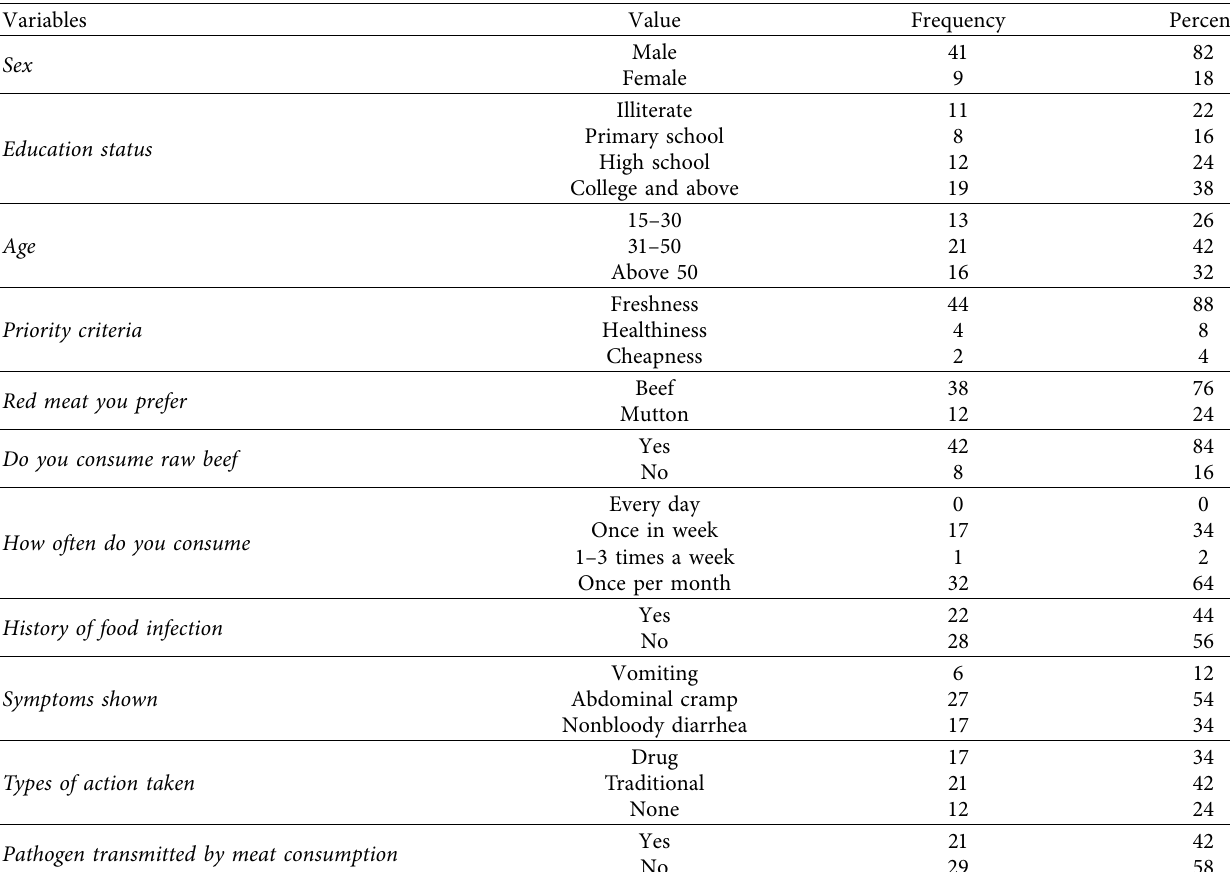
Table 3: Consumers’ knowledge, attitudes, and practices regarding meat preference and foodborne